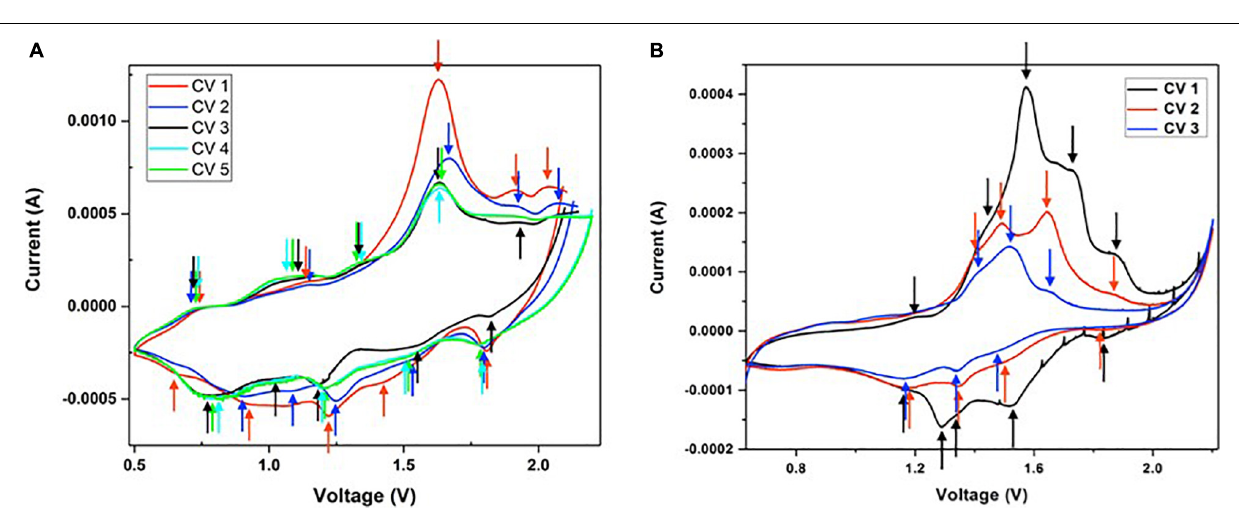
FIGURE 8 | Cyclic voltammograms of (A) VOP1 and (B) VOP2 in half-cells using Zn as reference and counter electrodes and 3 M ZnS0 4 .7H 2 0 as electrolyte at 1